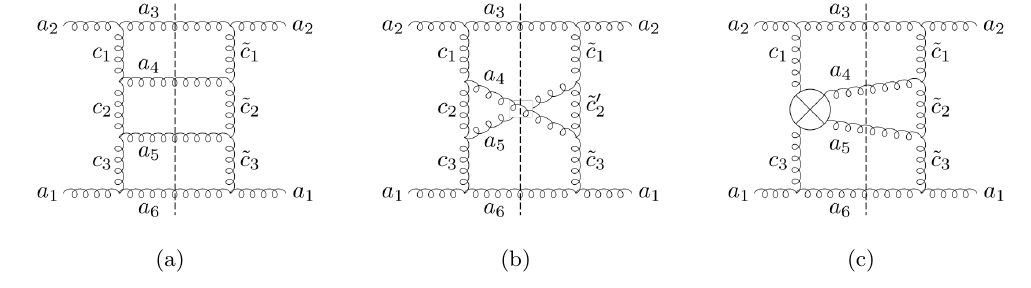
(cid:3) using the basis of Disp (cid:2) M (1) Figure 8 . Three of the colour structures contributing to M (0) ∗ 6 g 6 g one-loop colour structures in eq. (4.75). The remaining three colour structures can be obtained by interchanging a . A three-gluon vertex represents the adjoint generator F , while the ⊗ symbol 4 ↔ a 5 represents the fully symmetric trace d of eq. A